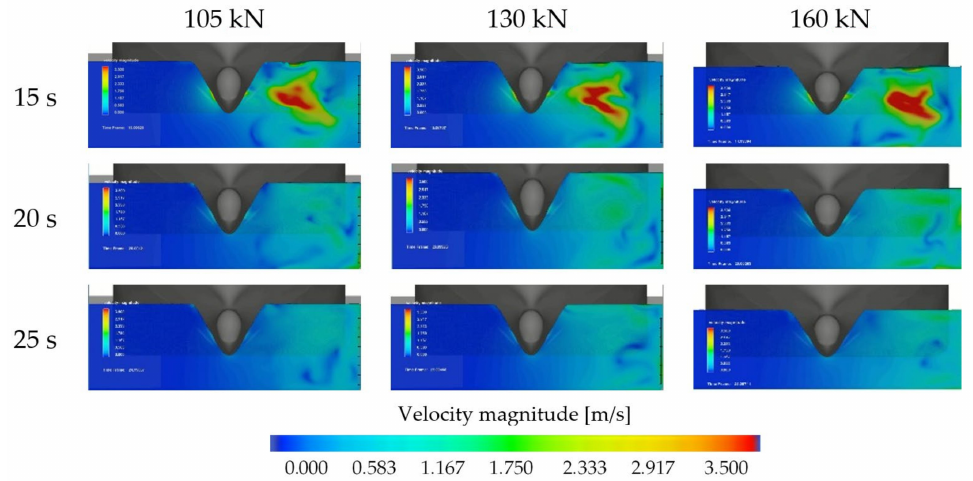
Figure 12. Bow thruster-generated flow distribution in the section of measuring C7 line during the time of simulation 15 s, 20 s and 25 s—both the bow thrusters operating for 10 s with thrusts of, respectively, 105 kN, 130 kN and 160 kN each.